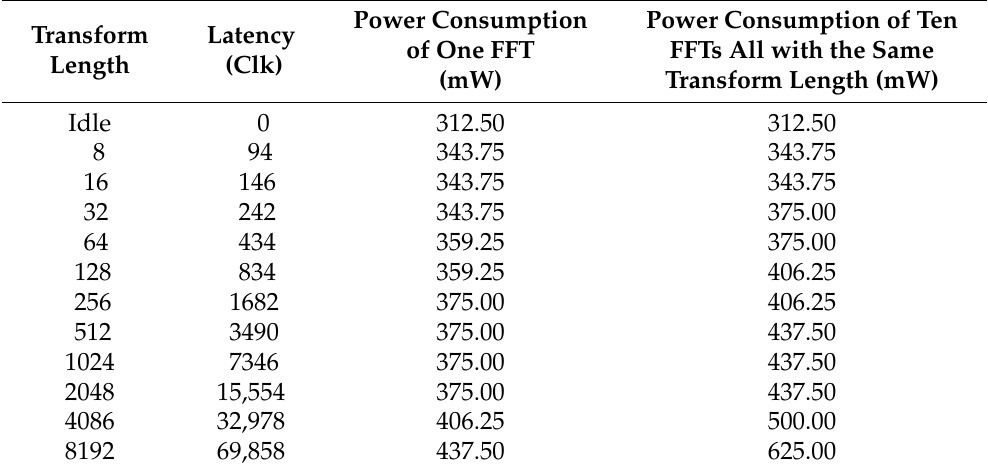
Table 3. The power consumption and latency of one-FFT and ten-FFT modules with various transform